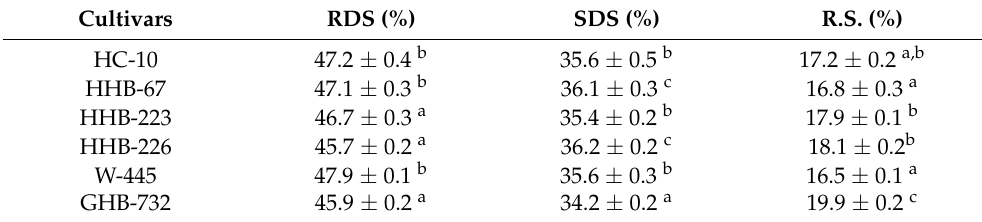
Cultivars RDS (%) SDS